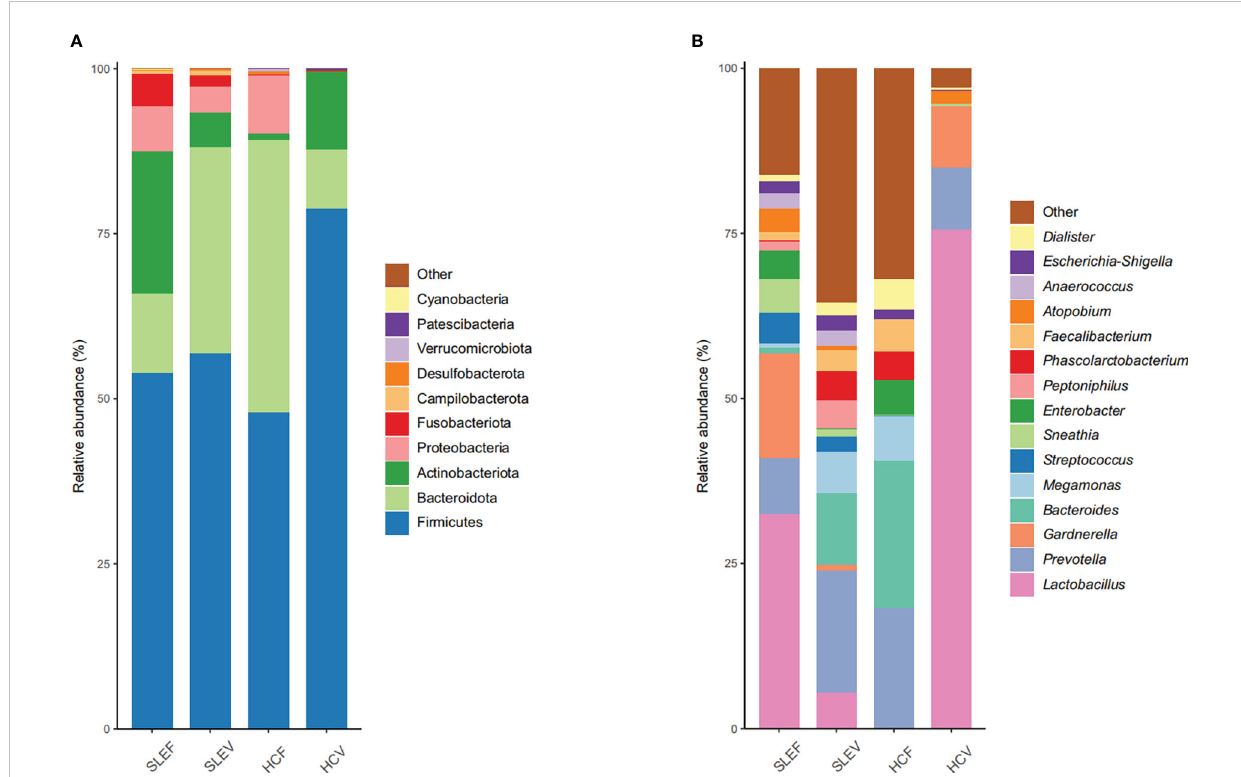
FIGURE 2 Microbial pro fi le at the phylum (A) and genus (B) level. Only the top 10 most abundant phyla and 15 most abundant genera are shown. HCF, HC feces; HCV, HC vagina; SLEF, systemic lupus erythematosus feces; SLEV, systemic lupus erythematosus